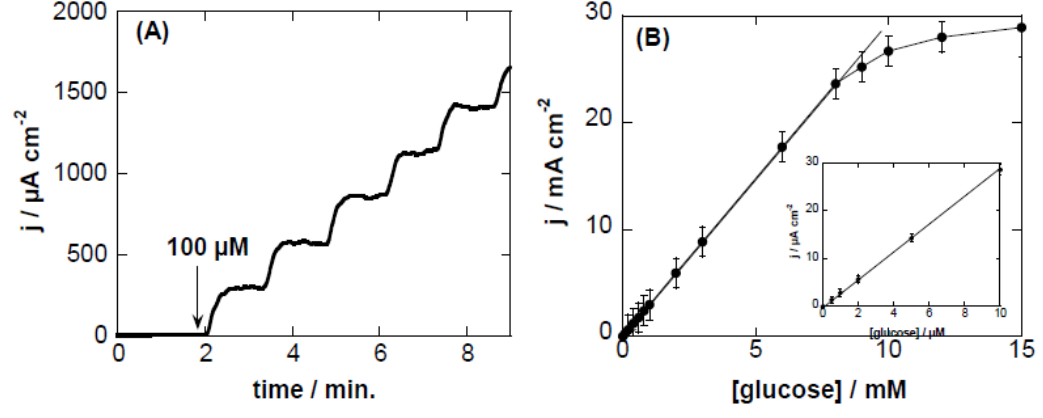
Figure 4. ( A ) Amperometric response curve of CQDs/Cu 2 O-modified GCE polarized at +0.55 V vs. Ag/AgCl upon successive additions of glucose (100 µ M) in 0.1 M NaOH (up to a total of 500 µ M); ( B ) Calibration curve for CQDs/Cu 2 O-modified GCE electrodes for the determination of glucose. The inset corresponds to a calibration curve for glucose concentrations of 0–10 µ